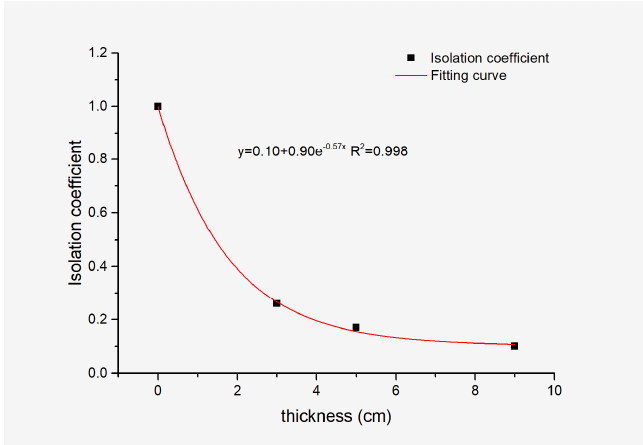
Figure 7. Fitting curve of the isolation coefficient in the Z-direction.